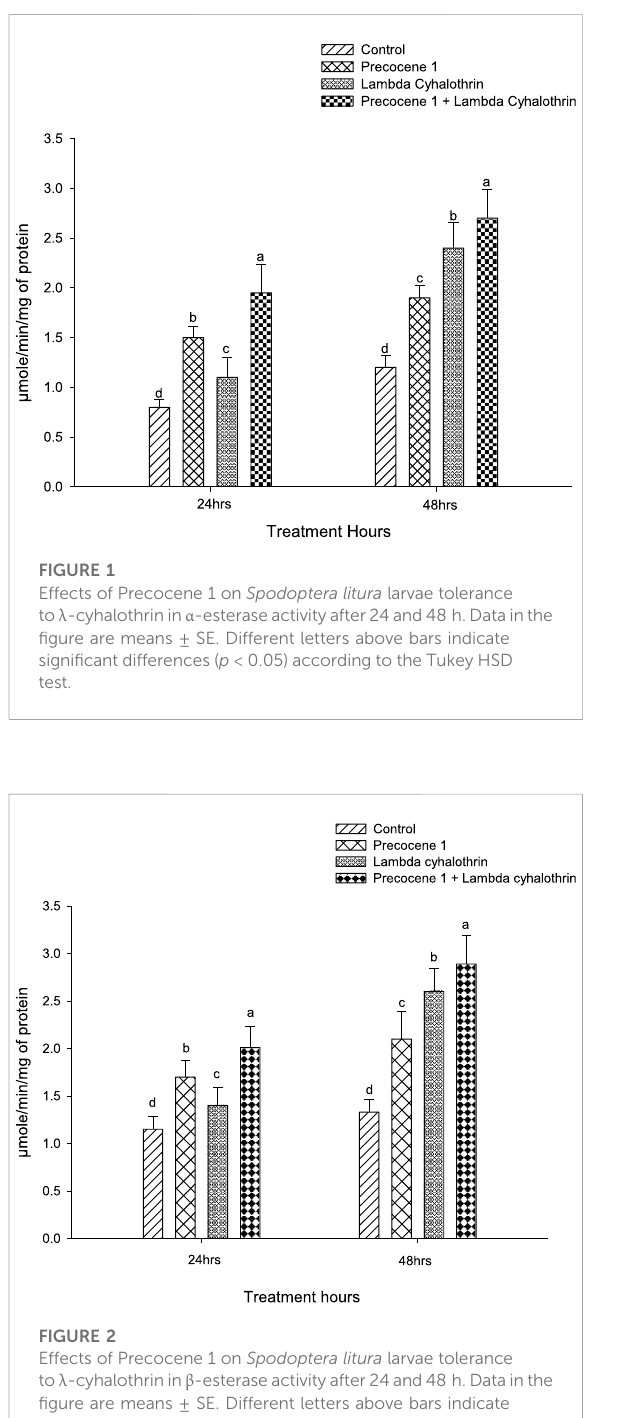
greater, being 1.89 and 2.11 in the larva of S. litura . The enzyme activity of S. litura was followed in the order of Precocene 1, λ - cyhalothrin, and the control as 1.29, 1.13, and 0.98 at 24 h of